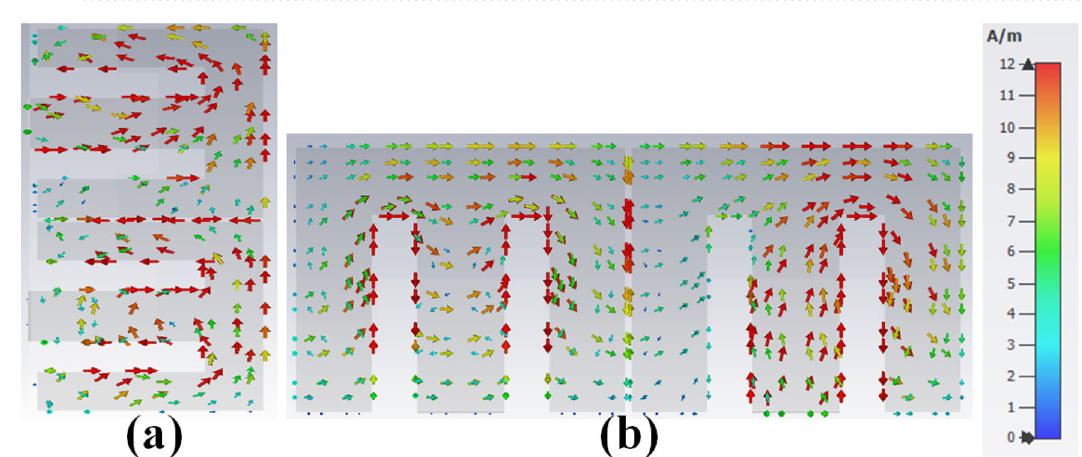
Figure 15. The density of surface current ( a ) Ant 1, ( b ) Ant 5 at 3.45